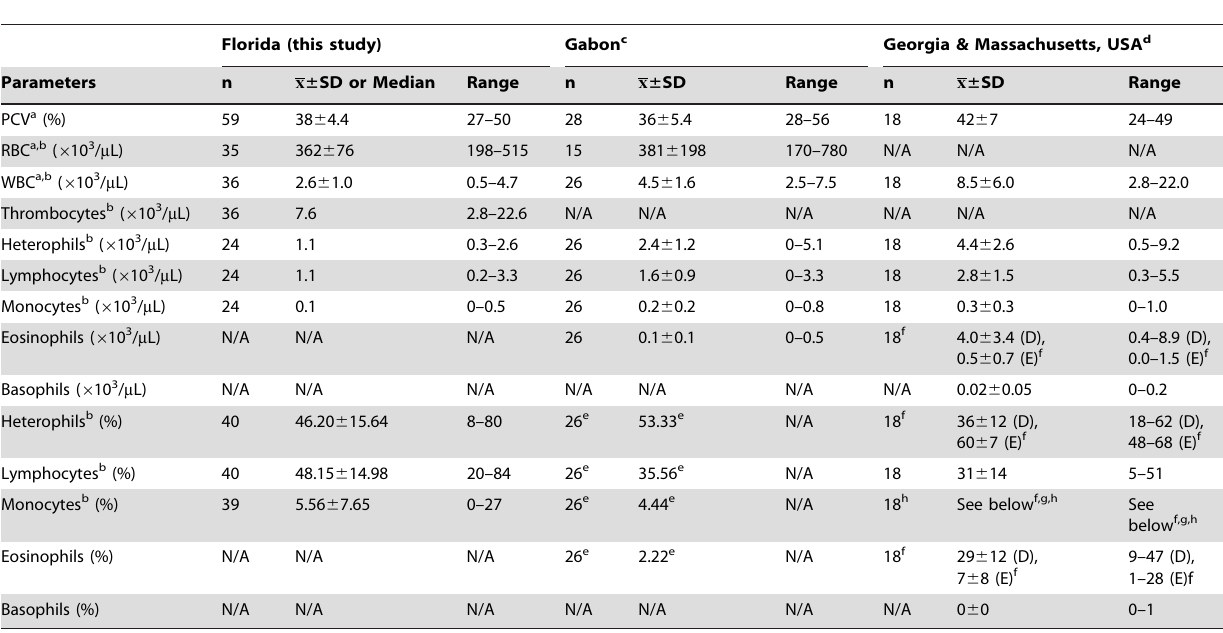
Table 2. Synopsis of hematologic values for leatherback sea turtles from the literature (Atlantic Ocean) and this study.